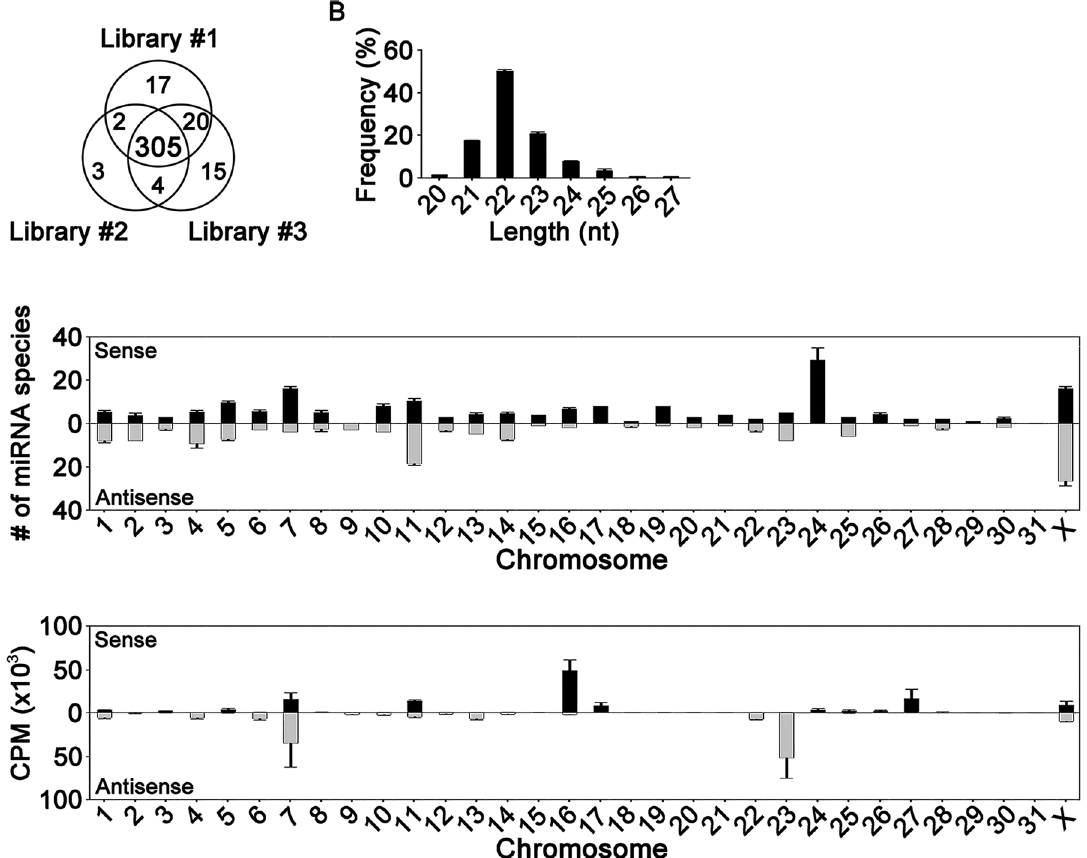
Fig 1. Sequencing of miRNAs in three horse plasma libraries. (A) Venn diagram representing the numbers of miRNA species identified in the libraries. (B) Length distribution of miRNAs. The x-axis represents sequence lengths, and the y-axis the occurrence frequency of miRNA species for each given length. (C, D) Chromosomal location of miRNA genes. The x-axes represent chromosome number, and the y-axes the numbers of miRNA species (C) and reads (D) on the respective chromosome. Black and gray bars represent sense and antisense strands, respectively. For (C) and (D), data are shown as mean ± S.D. (n =